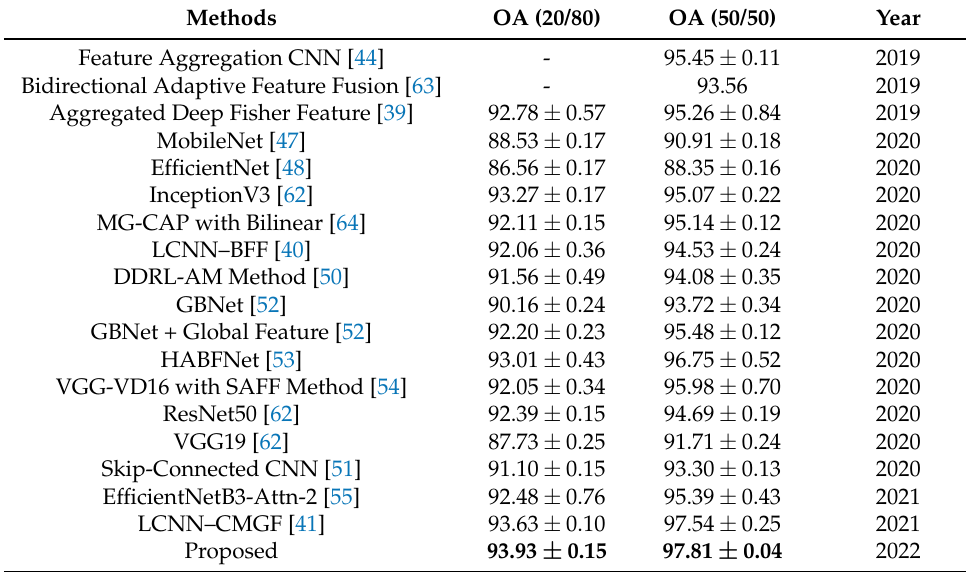
Table 9. OA comparison on AID